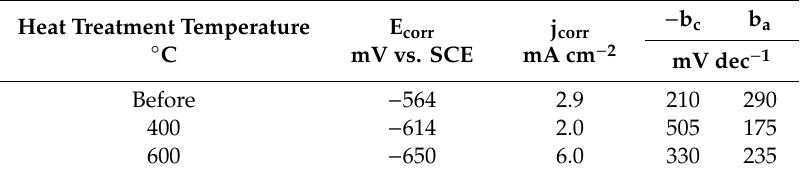
Table 3. Corrosion electrochemical parameters of the Al / Cu alloy on the Al substrate.